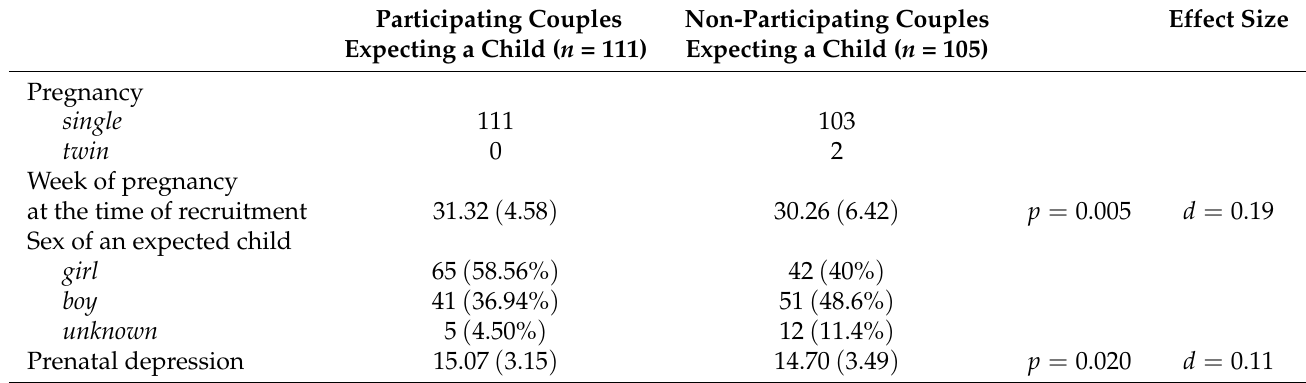
Table 2. Characteristics regarding pregnancy and children of participating and non-participating expectant